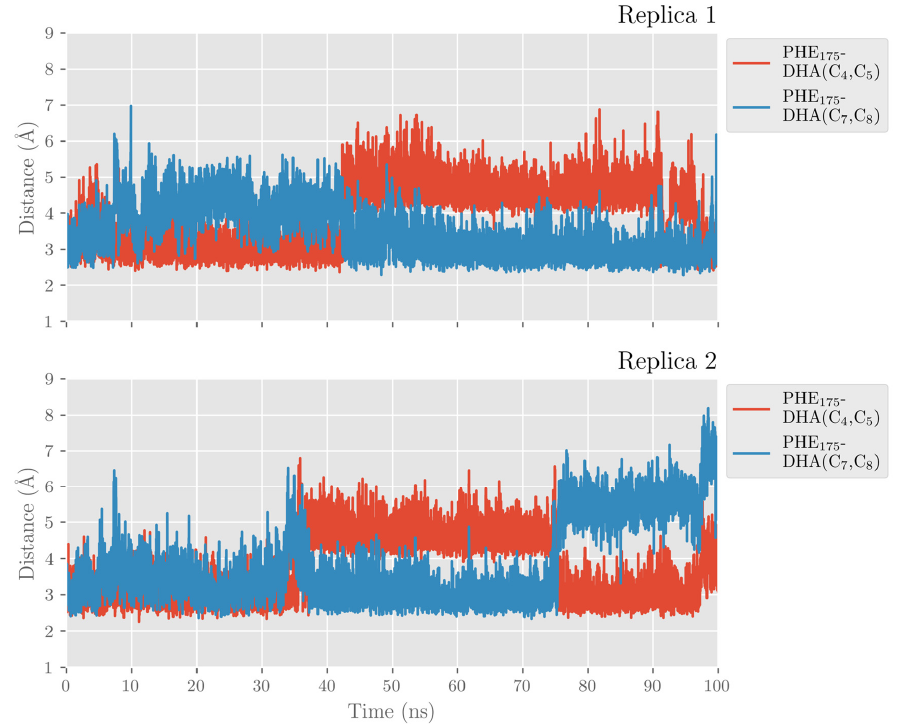
Figure 18. Distances between Phe175 sidechain and the closest atom of the Δ 4 and Δ 7 double bonds versus time for the MD replica 1 and for replica 2 in pigALOX15-mini-LOX. As for H 12 -OH − , H 9 -OH − , and H 15 -OH − distances along the MD replica 1 and replica 2, we have plo tt ed them in Figure 19. H 12 remains the closest to the OH- group of the cofactor the main part of the trajectory. H 9 and H 15 present a similar number of precatalytic structures when considering both MD replicas. However, when H 9 is closer, H 15 is farther away, and vice versa. Our MD simulation indicates that the DHA binding mode in pigALOX15-mini-LOX could lead to 14-H(p)DHA as a major product but also, with less probability, to 11-H(p)DHA and 17-H(p)DHA as minor products. Experimentally, Kühn and coworkers obtained a relative share of 76.4% for 14-H(p)DHA and 23.6% for 17- H(p)DHA for the speci fi city of pigALOX15 [21].